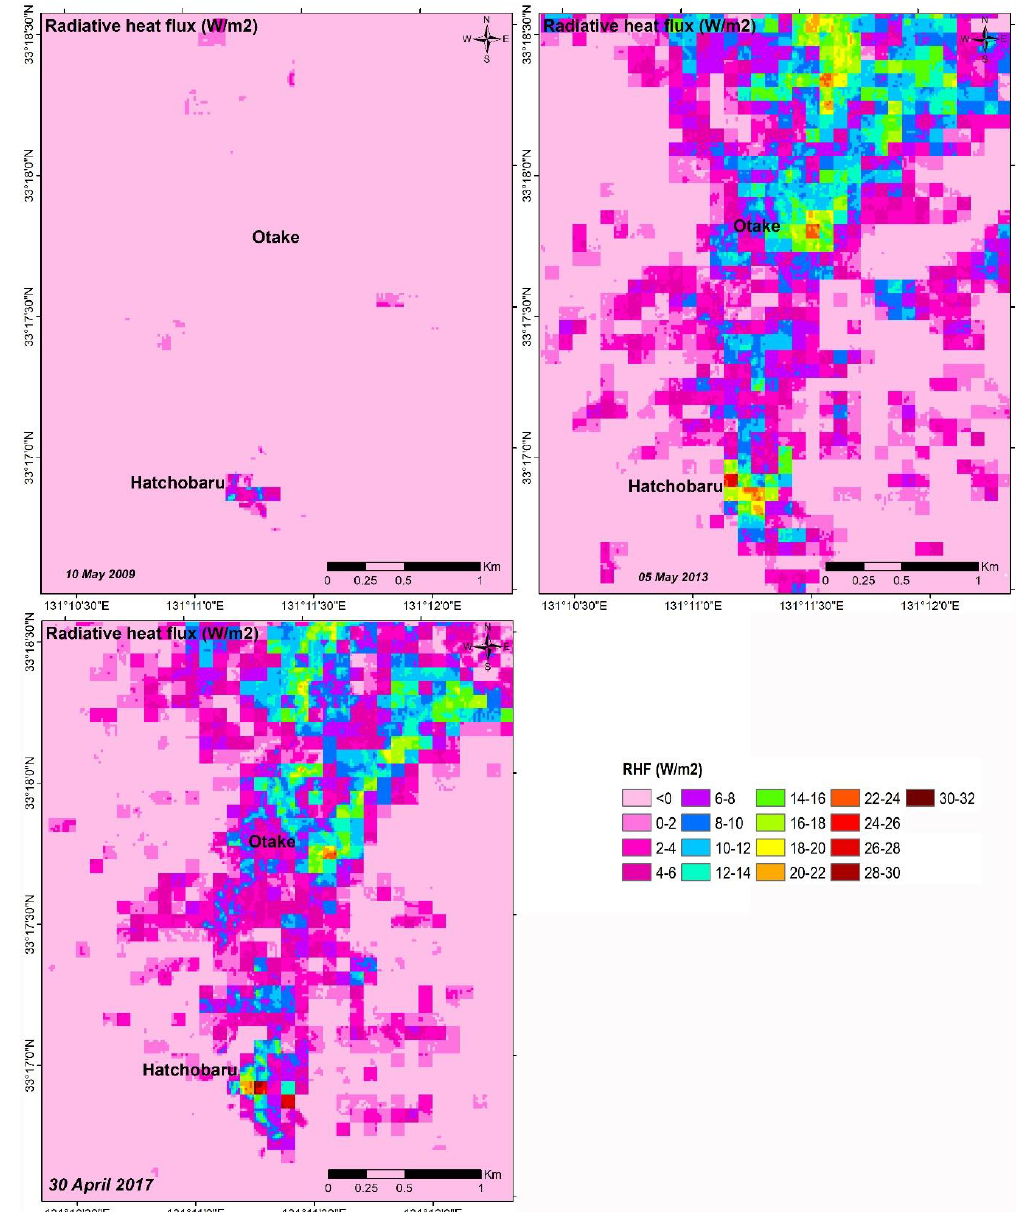
Figure 6. Radiative heat flux (W/m 2 ) maps derived from the ASTER thermal infrared images of the Hatchobaru–Otake geothermal area for 2009, 2013, and 2017.